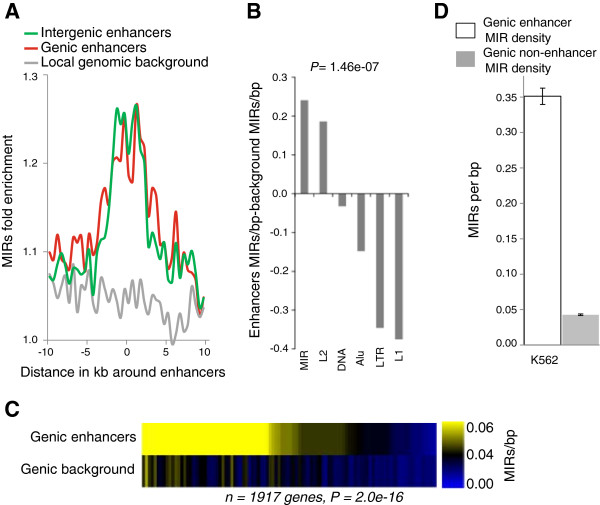
MIRs are highly concentrated within enhancers. (A) Fold enrichment of MIRs in-and-around all genic enhancers (red) and intergenic enhancers (green) relative to the local genomic background (gray). (B) Average difference between transposable element densities around enhancers and around genomic background. (C) Average MIR densities for genic enhancers compared to genic background in K562 (significance level computed using the paired t test). (D) Average (±standard error) densities of MIRs in the core 200 bp of genic enhancers (white bar) versus the corresponding non-enhancer sequences of the same genes (gray).